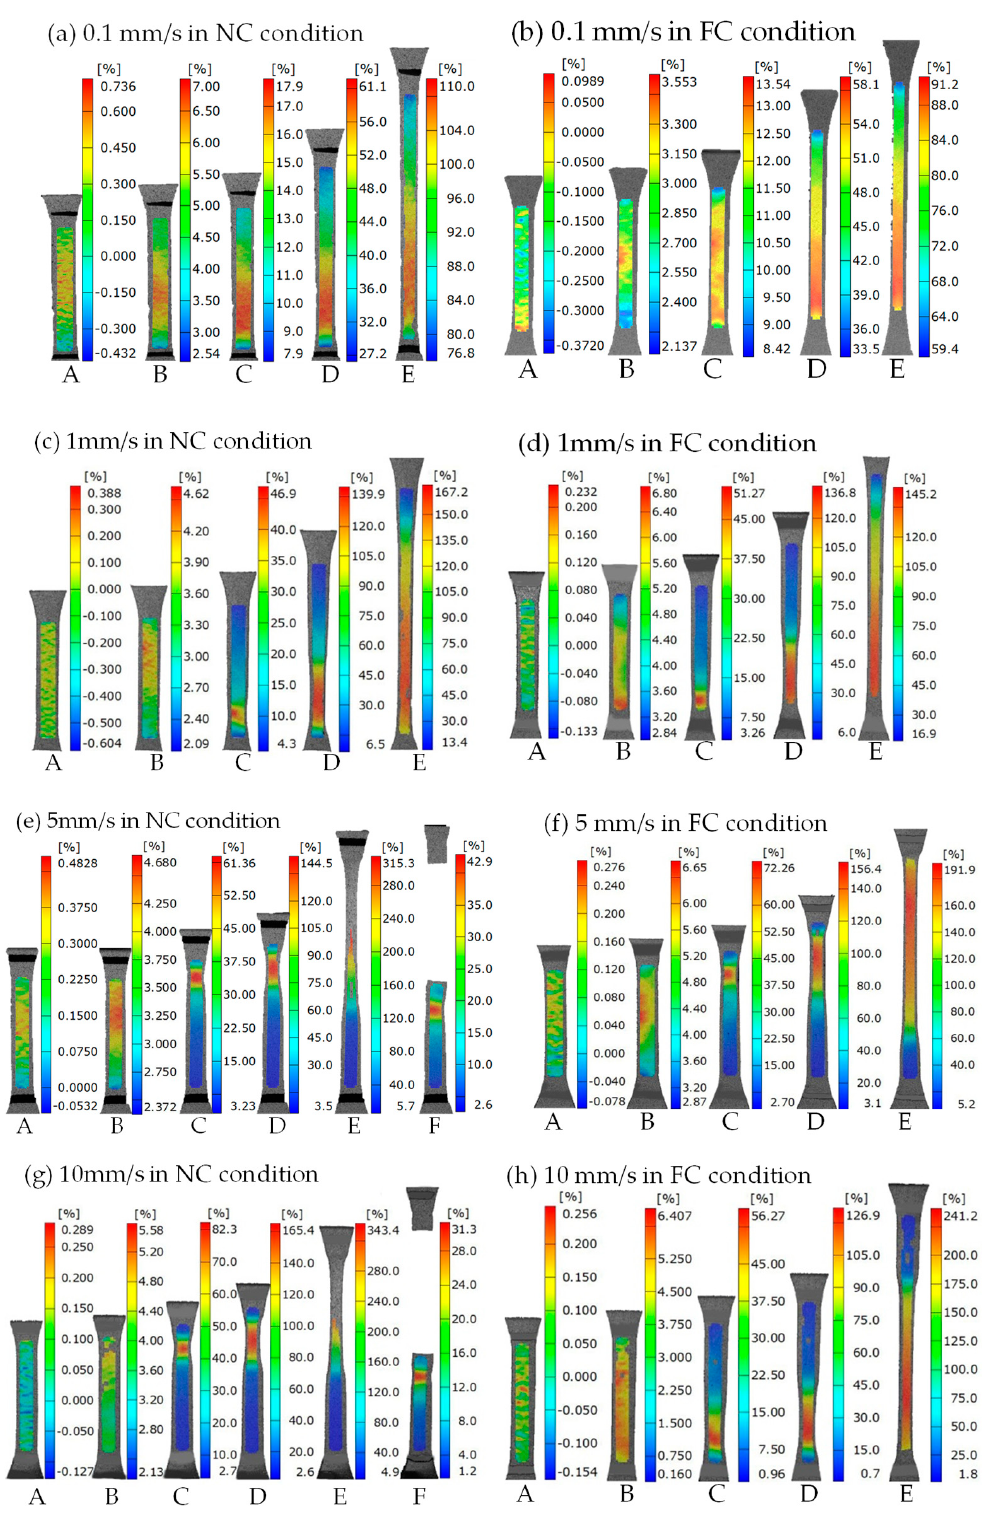
Figure 6. Strain contours at the loading rates of ( a ) 0.1 mm / s in the natural convection (NC) condition; ( b ) 0.1 mm / s in the forced convection (FC) condition; ( c ) 1 mm / s in the NC condition; ( d ) 1 mm / s in the FC condition; ( e ) 5 mm / s in the NC condition; ( f ) 5 mm / s in the FC condition; ( g ) 10 mm / s in the NC condition and ( h ) 10 mm / s in the FC condition. (Point F in Figure 6e,g denotes the fracture of the